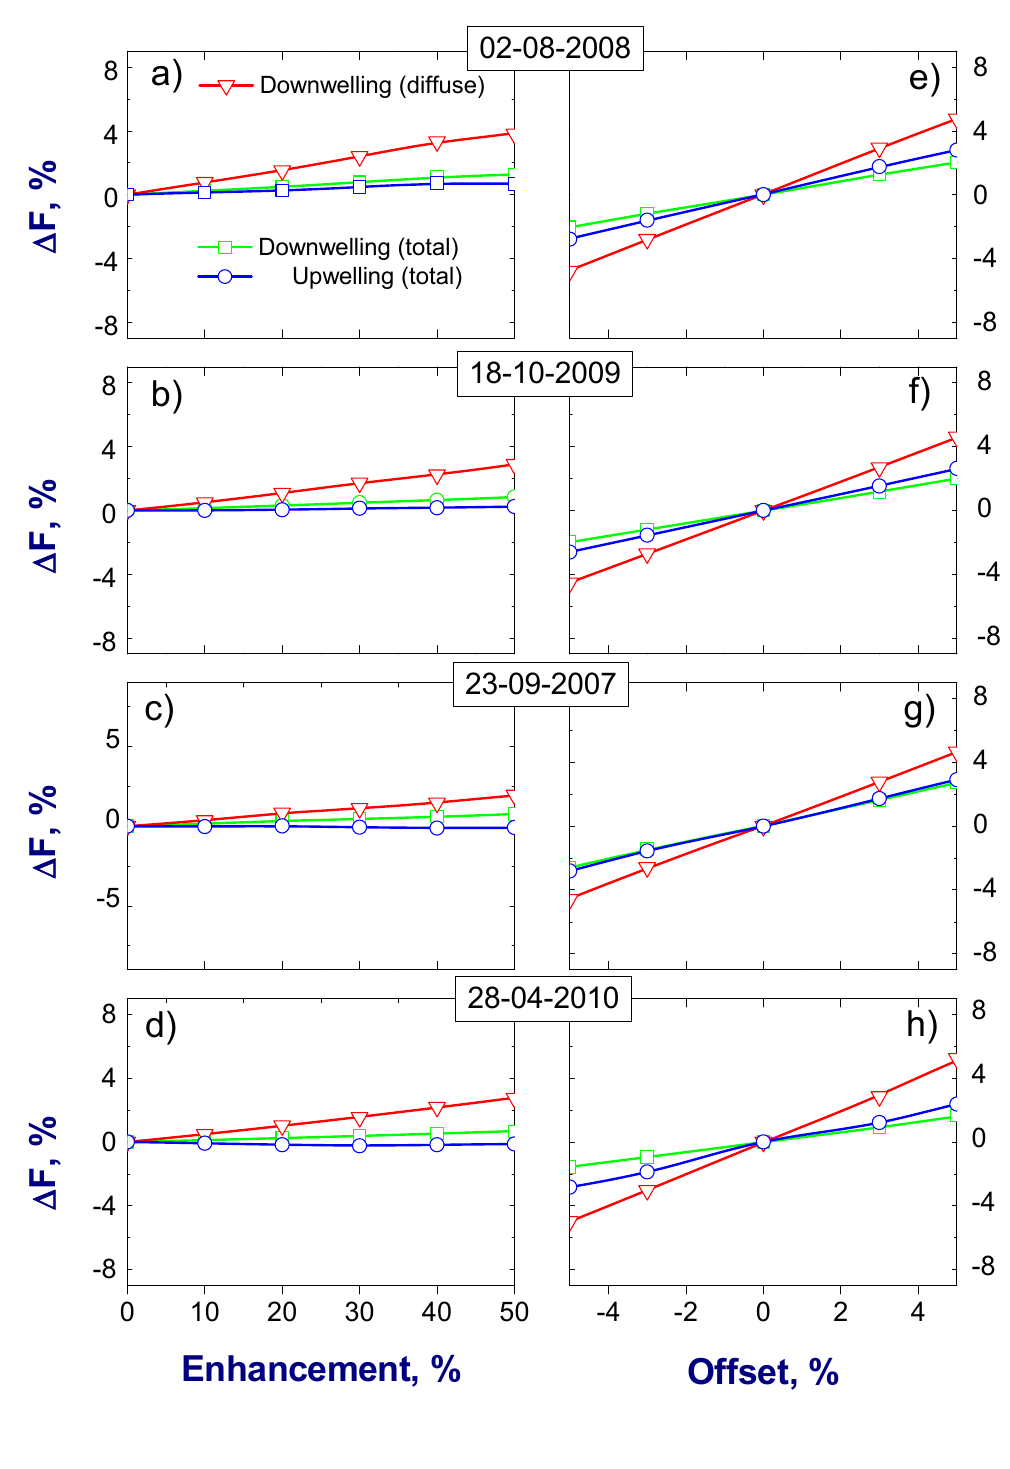
Figure 10. The same as Figure 5, except that these differences correspond to the upwelling total (blue), downwelling total (green), and downwelling diffuse (red) fluxes at the TOA (blue) and BOA (green and